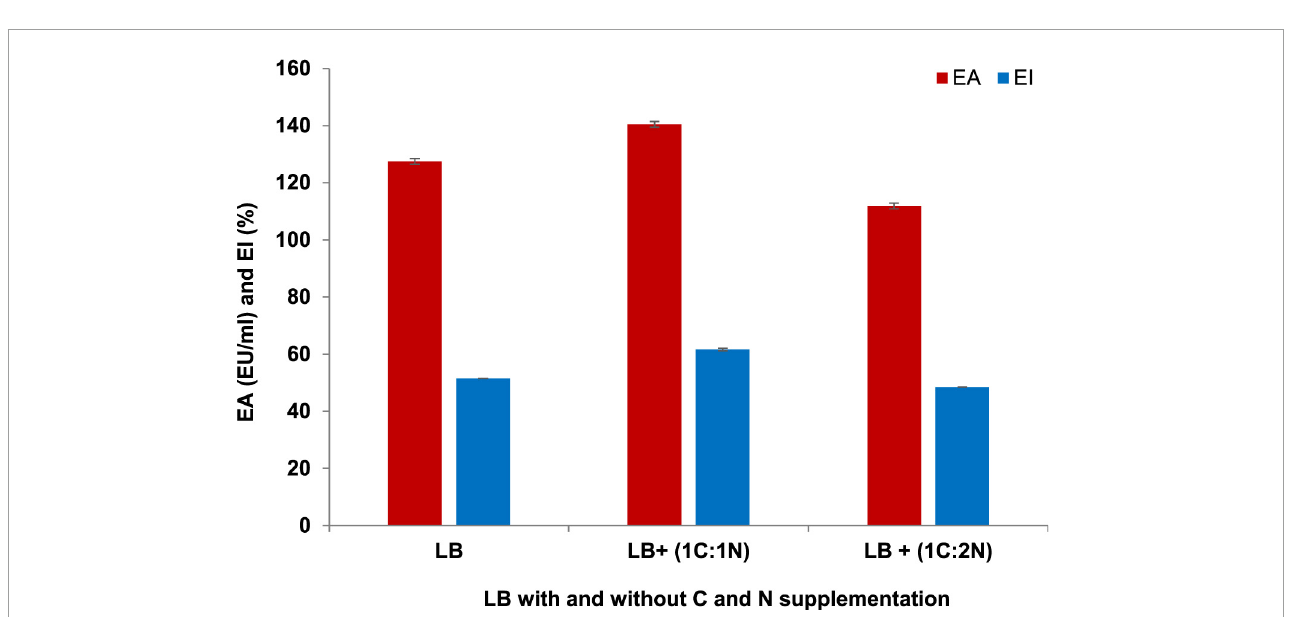
FIGURE5 Effect of C/N ratio on BE production by Parapedobacter